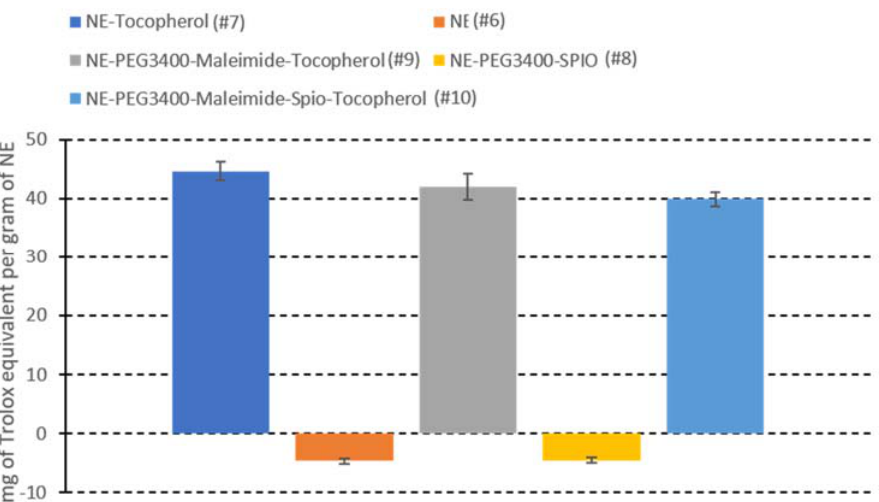
Figure 8. Antioxidant properties of the tested NE formulations expressed as mg of Trolox equivalent per gram of NE ( n = 3).